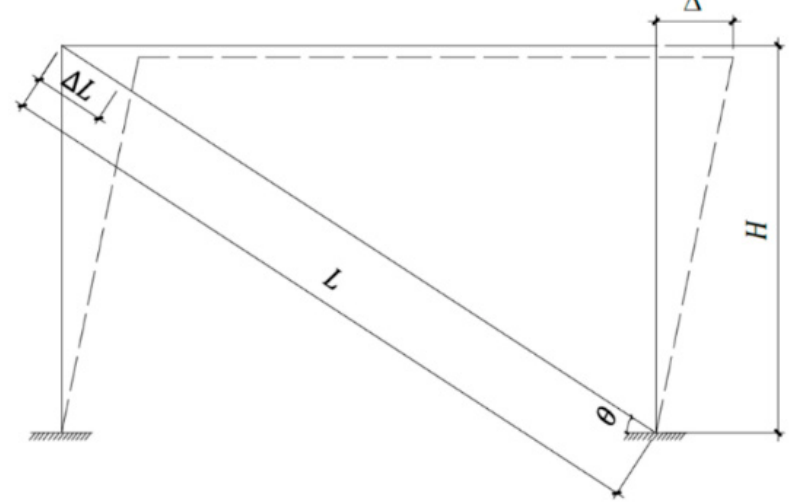
Figure 2. Calculation principle diagram of the brace’s clearance.